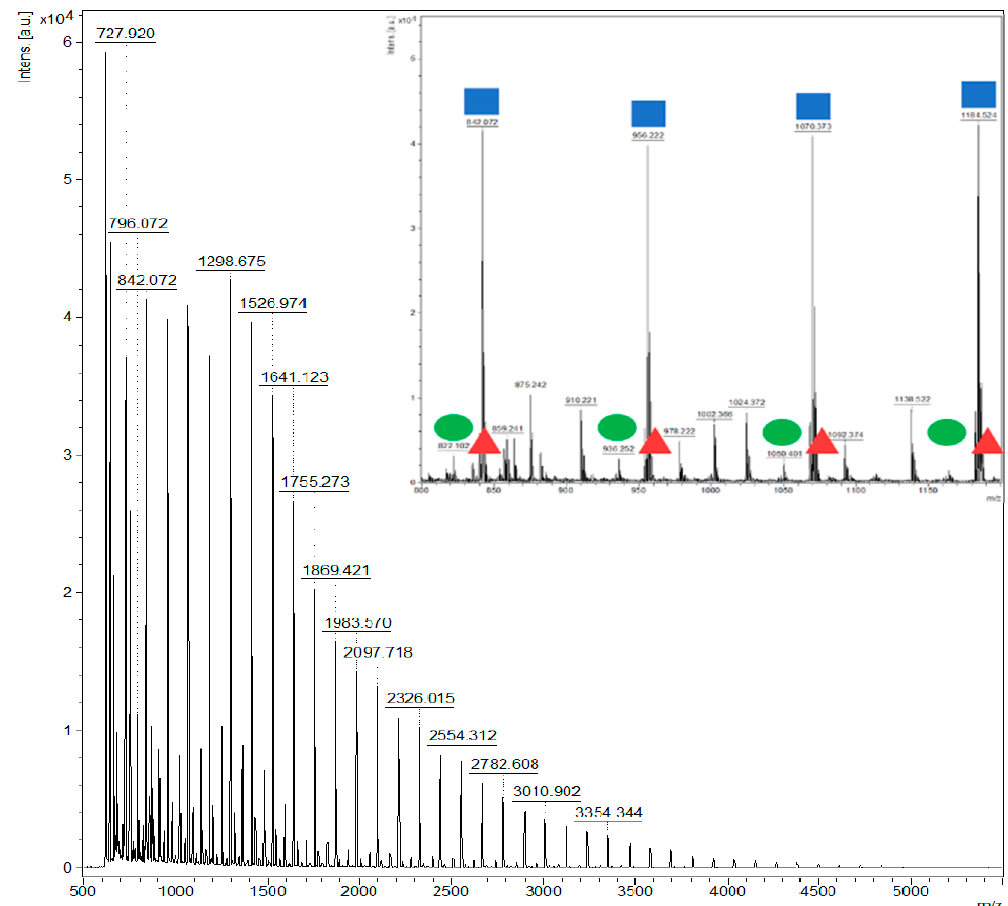
Figure 2. Matrix-assisted laser desorption ionization time-of-flight mass spectrometry (MALDI TOF-MS) spectrum of reaction products synthesized from ε -caprolactone (ECL) and L-malic acid (L-MA) at a 2:1 molar ratio using GF-CalB-IM as the biocatalyst in solventless system at 80 °C. Inset: Detailed view of the m/z range 800–1200, highlighting the oligomers of interest ( are linear oligoesters with 1 unit of MA, are cyclic oligoesters with 1 unit of MA, and are linear oligoesters with 2 units of MA). Table 1. Influence of the ε -caprolactone: malic acid molar ratio on the composition of the reaction products obtained in the presence of Novozyme 435 in a solventless system.